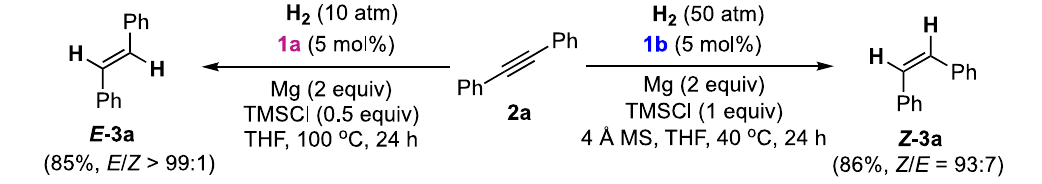
effect on controlling the E / Z selectivity. The stereoselectivity of E -ole fi n relative to Z -stereomer was determined by GC